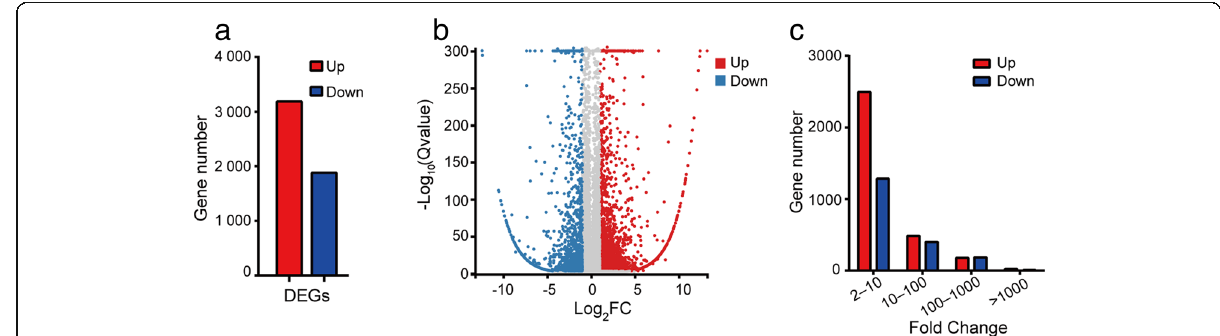
Fig. 3 The distribution of DEGs in wingless and wing aphids. a Number of DEGs at FC (fold change) > 2 and P < 0.001 in the comparison between wingless and wing cotton aphids. b Volcano plot of DEGs. c Number of DEGs at different fold change